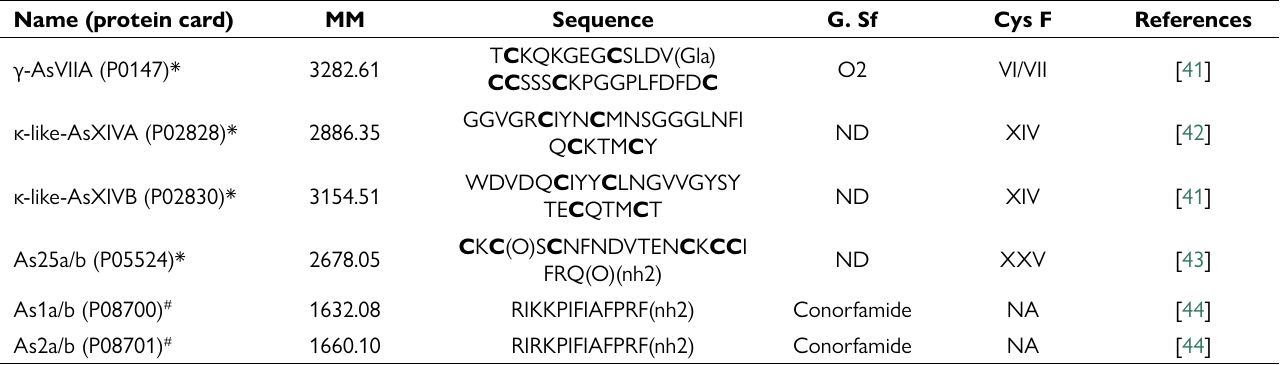
Table 4. Conopeptides identified in the venom of Conus cancellatus .